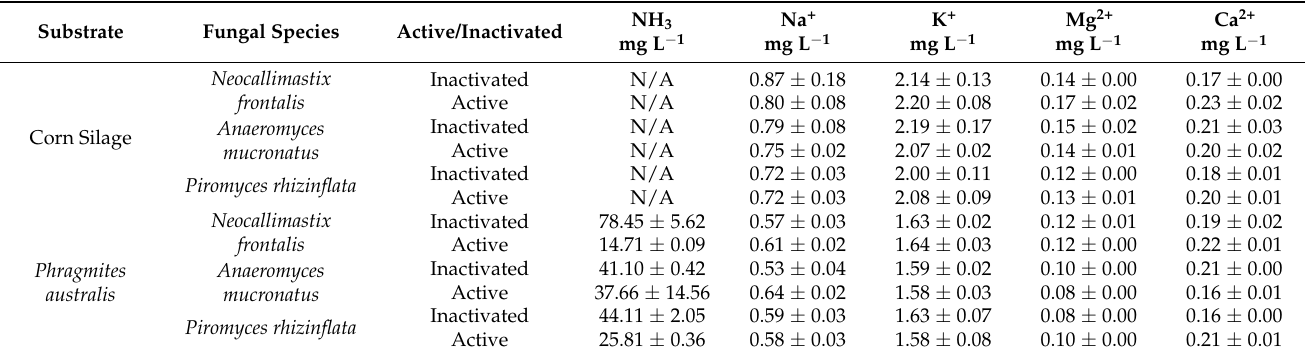
Table 2. Effect of ammonia and alkaline metals in the bioagumentation of three different anaerobic fungal species. Substrate Fungal Species